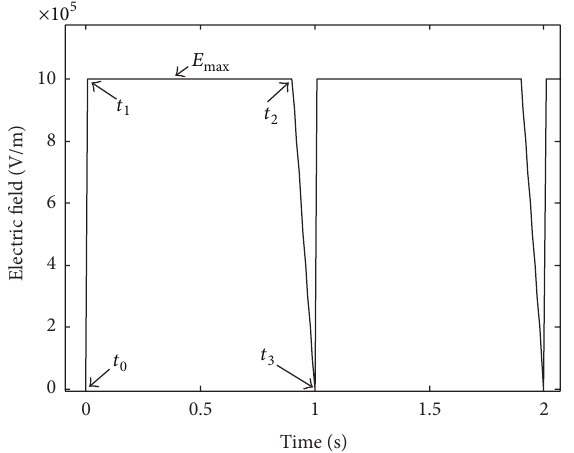
Figure 4: Applied electric pulse to the electrocaloric element.